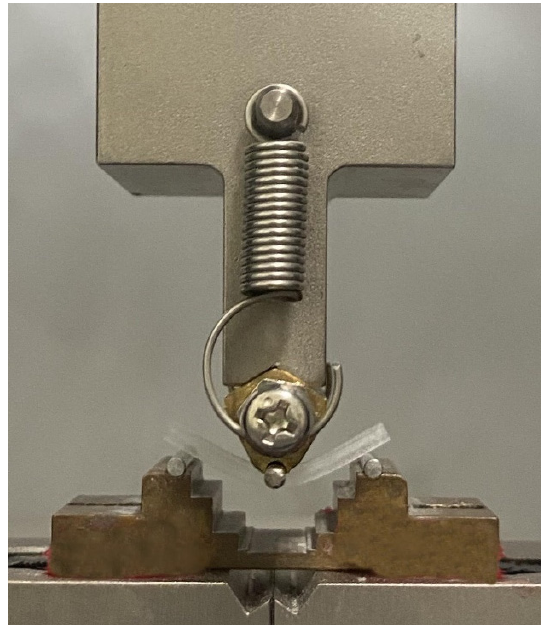
Figure 6. Three-point bending test setup.